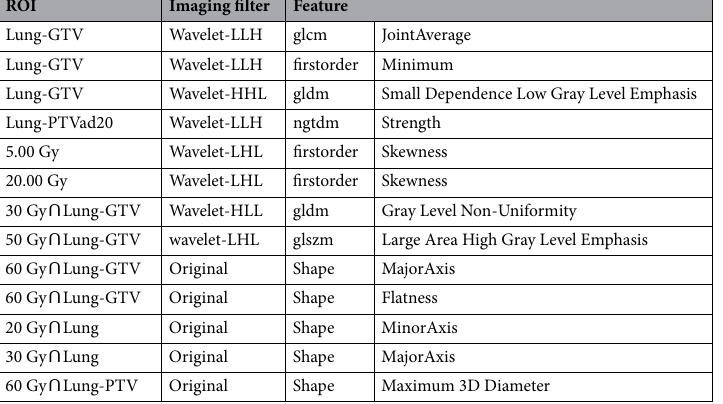
Table 4. Selected features by least absolute shrinkage and selection operator regression in the multi-region radiomics